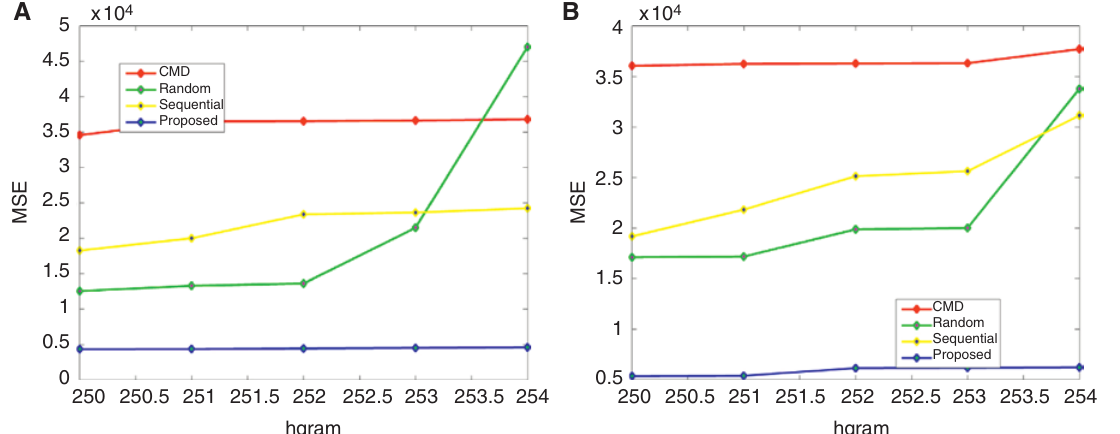
Figure 10: MSE after Equalization Attack. (A) Image 1. (B) Image